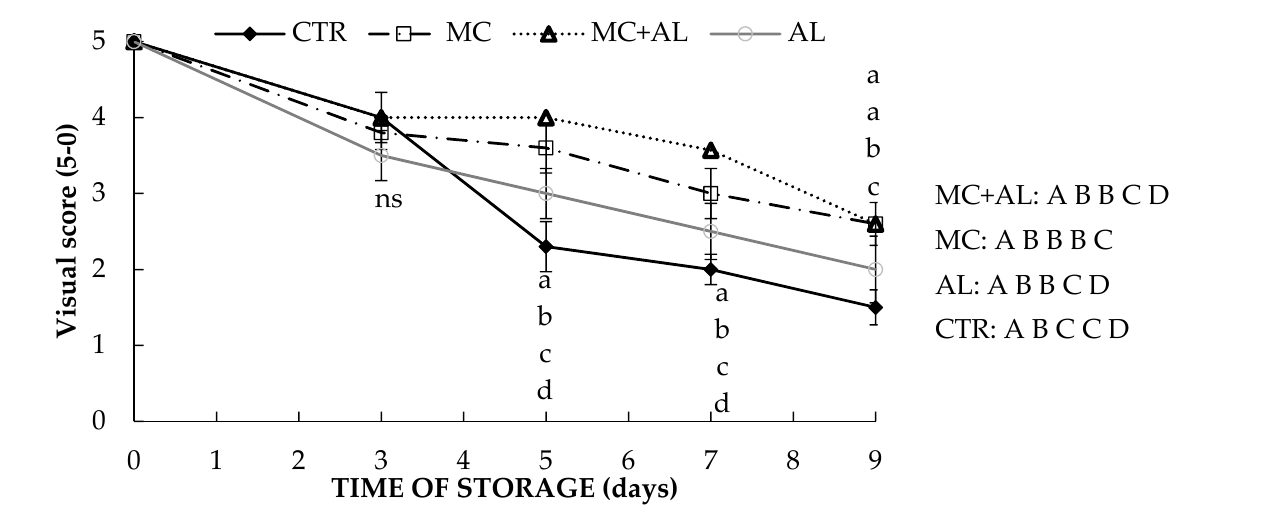
Figure 1. Visual score of fruit slices of Actinidia deliciosa (Liang, Ferguson) coated with O. ficus-indica (OFI) mucilage (MC), or mucilage + A. arborescens (MC+AL) or A. arborescens (AL) not treated (CTR), just after being coated (0) and at 3, 5, 7, 9 days of storage at 5 °C. Different lowercase letters indicate significant differences between treatments at each sampling date. Different capital letters indicate significant differences between sampling date for the same treatment. Tukeys’ significant test was applied at p ≤ 0.05. Data are means ± S.E. (n = 3).